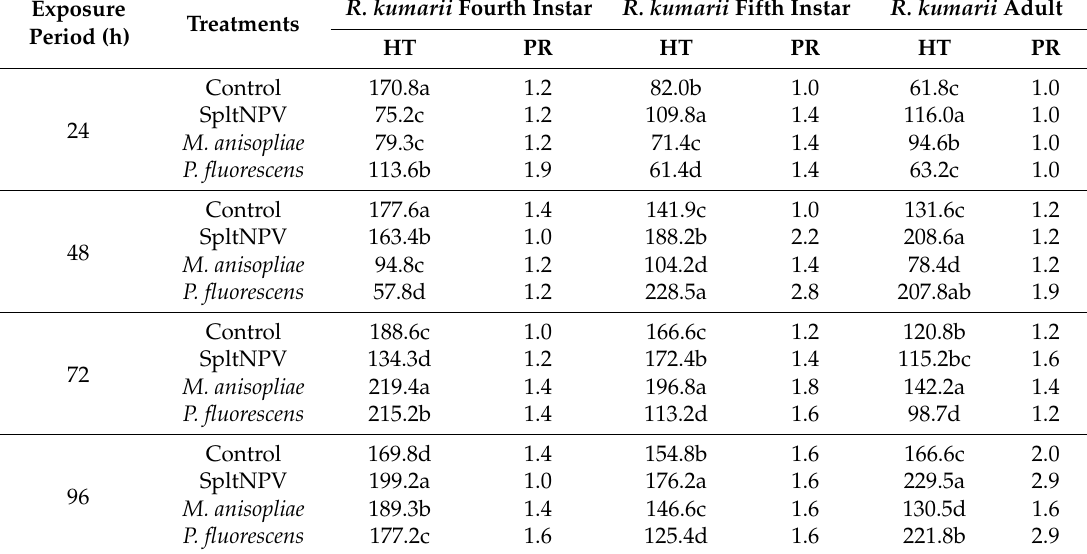
Table 2. Effect of Metarhizium anisopliae -, Spodoptera litura nucleopolyhedrovirus (SpltNPV)-, and Pseudomonas fluorescens -infected Spodoptera litura larvae on the handling time (HT: number of minutes) and predatory rate (PR: number of prey/predator/day) of R. kumarii life stages at 24, 48, 72, and 96 h, compared to the untreated control.